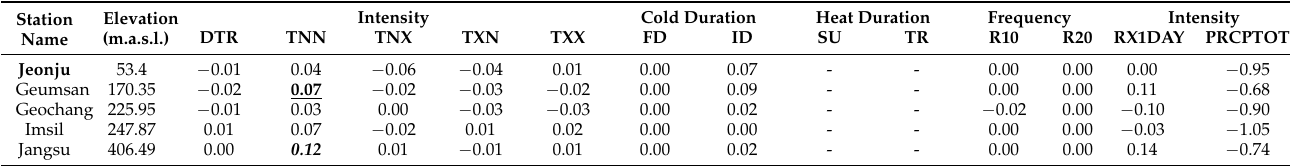
Table A6. Trend magnitudes during winter season (SON) in the UGRB for 33 years (1988–2020).